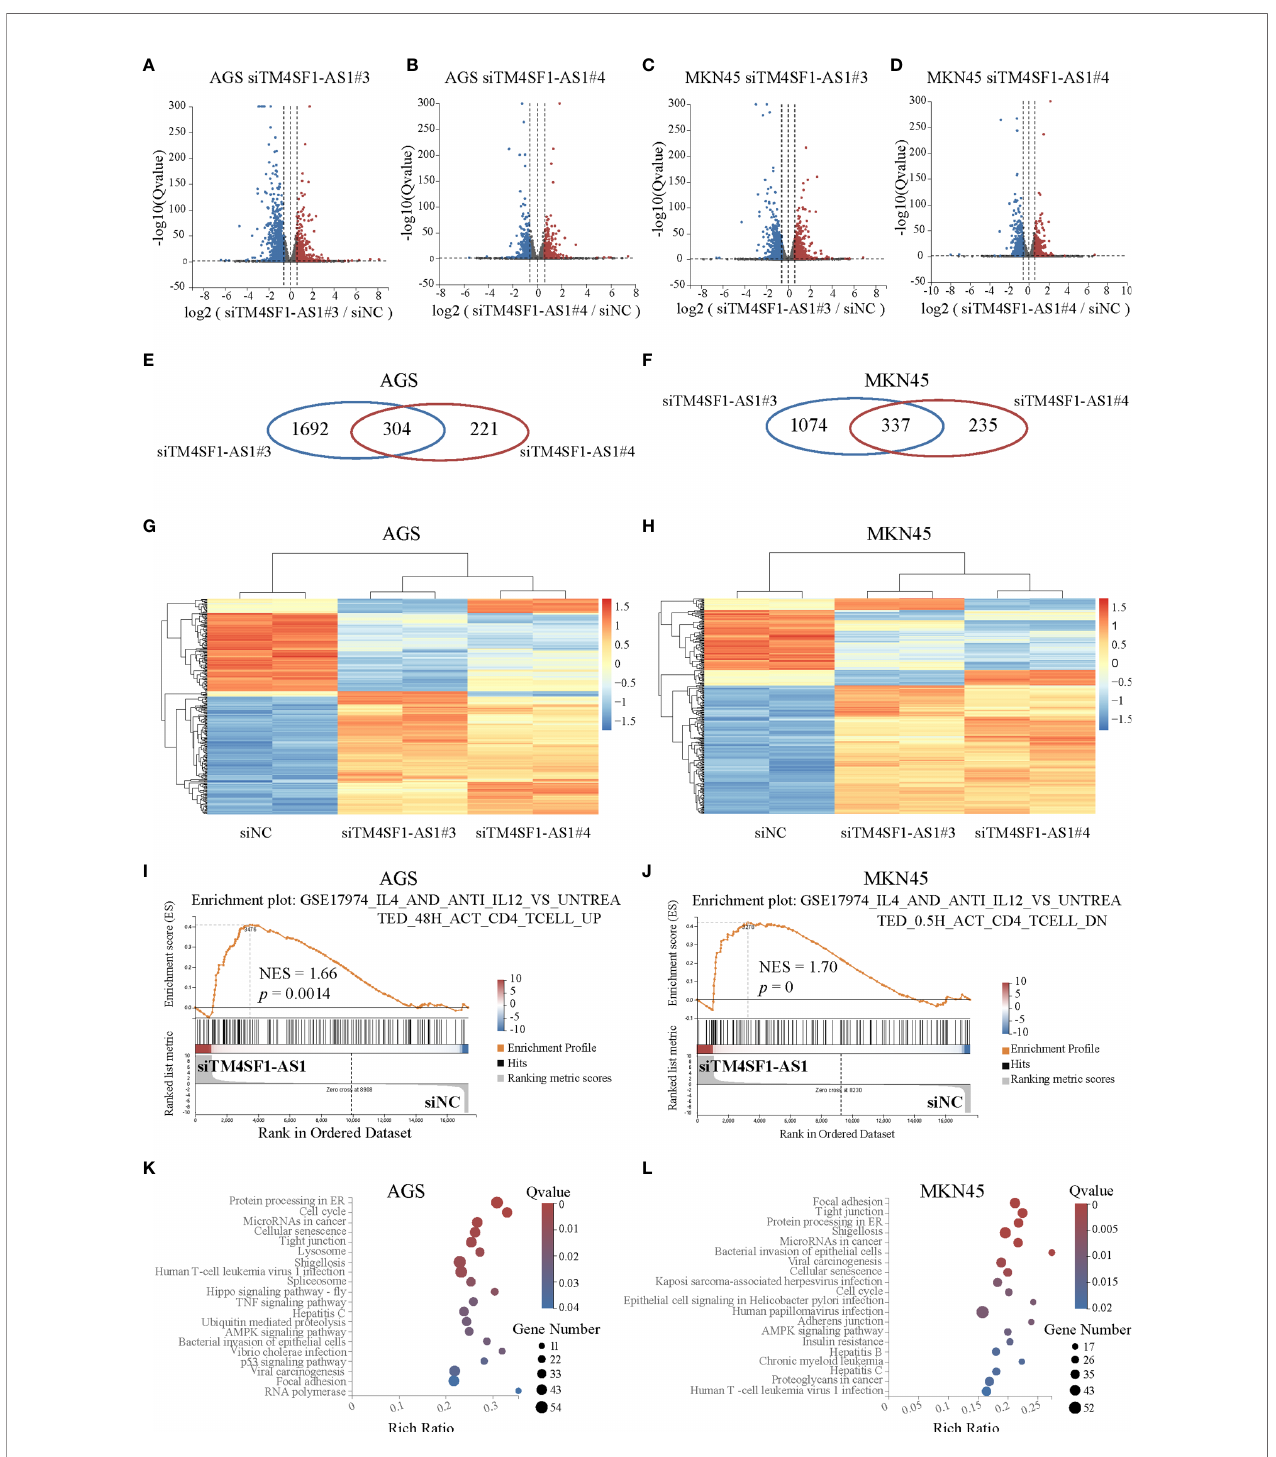
FIGURE 8 | Pathway analysis of TM4SF1-AS1 knockdown in two STAD cells. (A – D) Volcano map showing the up- and down-regulated genes after TM4SF1-AS1 knockdown in AGS and MKN45 cells with two siRNA targets (siTM4SF1-AS1#3 and siTM4SF1-AS1#4). The red dots indicate up-regulated genes, and blue dots signify down-regulated genes. (E, F) Venn diagram displaying the differentially expressed genes by the intersection of siTM4SF1-AS1#3 and siTM4SF1-AS1#3 in (E) AGS and (F) MKN45 cells. (G, H) Heatmap showing the up- and down-regulated genes after TM4SF1-AS1 knockdown in (G) AGS and (H) MKN45 cells with siTM4SF1-AS1#3 and siTM4SF1-AS1#4. The red dots indicate up-regulated genes, and blue dots signify down-regulated genes. (I, J) GSEA analysis was performed on (I) AGS and (J) MKN45 cells following TM4SF1-AS1 knockdown. (K, L) KEGG analysis was performed on the changed genes in (K) AGS and (L) MKN45 cells after TM4SF1-AS1 knockdown with siRNAs. RNA-seq data of TM4SF1-AS1 knockdown in AGS MKN45 cells was from this